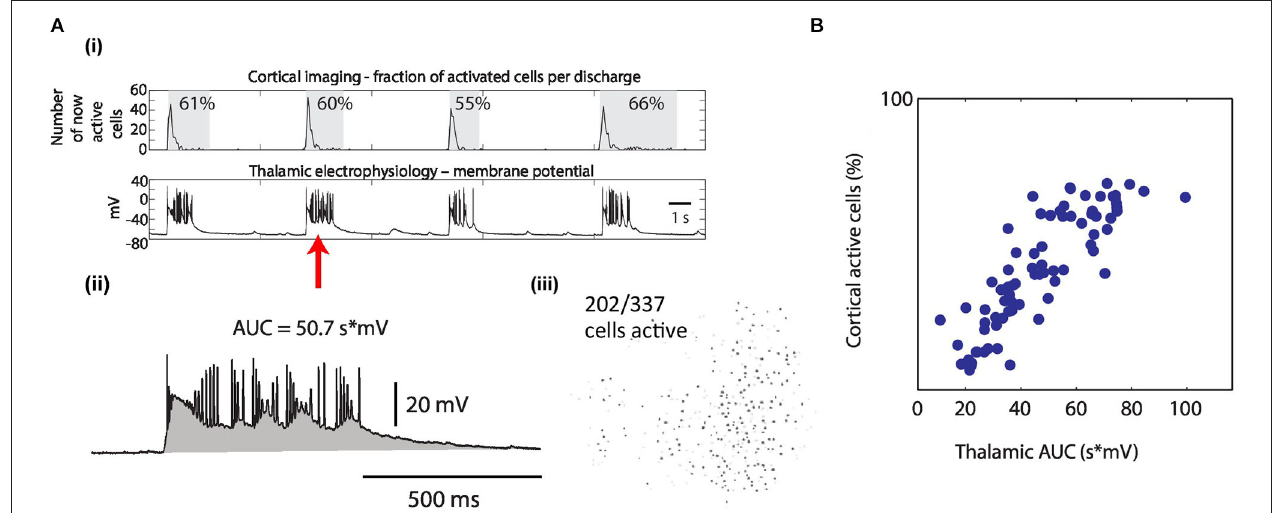
were measured as the percentage of activated cells of ever activated cells (in this example 202/337 = 60%). (B) Resulting discharge intensities in cortex plotted against intensities of the same discharges in thalamus, revealing the correlation of epileptiform activity between both brain areas (linear correlation coefficient = 0.85 in this example). Each dot represents one discharge quantification obtained from cortical imaging (all from the same FOV) and from the corresponding, simultaneous thalamic whole-cell